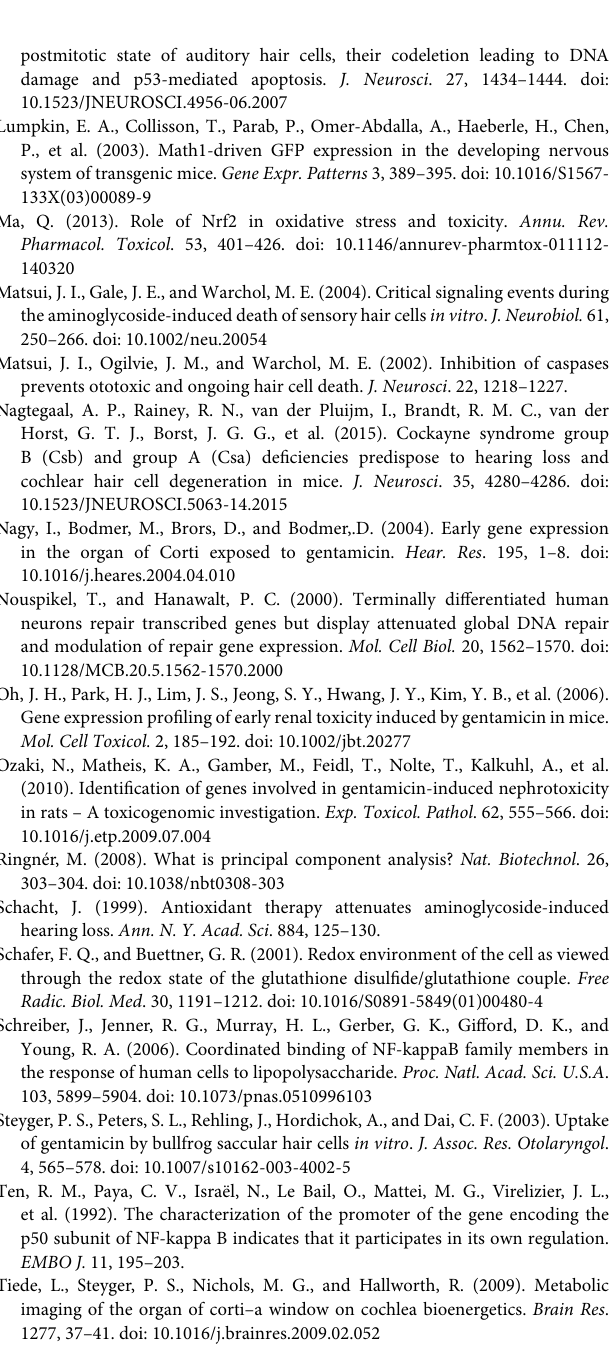
upregulated target genes; green, significantly downregulated target